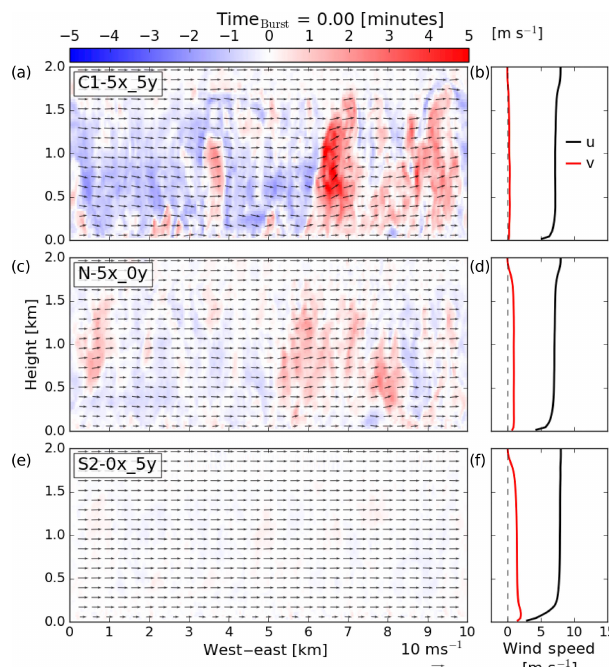
Figure 4. Vertical cross sections of vertical velocity and average profiles of the u - and v -component winds for the C1–5x_5y (a, b) , N–5x_0y (c, d) , and S2–0x_5y (e, f) cases at the start of the down- burst runs. Cross sections are taken along the east–west axis at the y location where the maximum vertical velocity occurs. Filled con- tours show vertical velocity (ms − 1 ) with arrows representing the u − w wind field. The domain average u - and v -component wind speed profiles are shown in the right column in black and red, re-